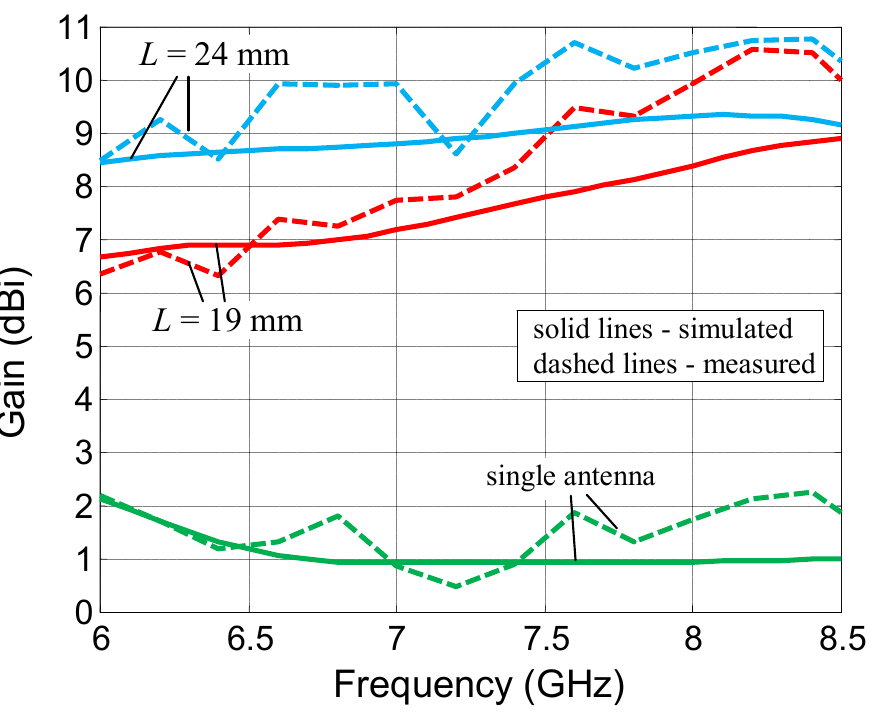
Figure 6. Simulated and measured gain of proposed antennas in direction perpendicular to antenna surface (along +/ − x- axis).